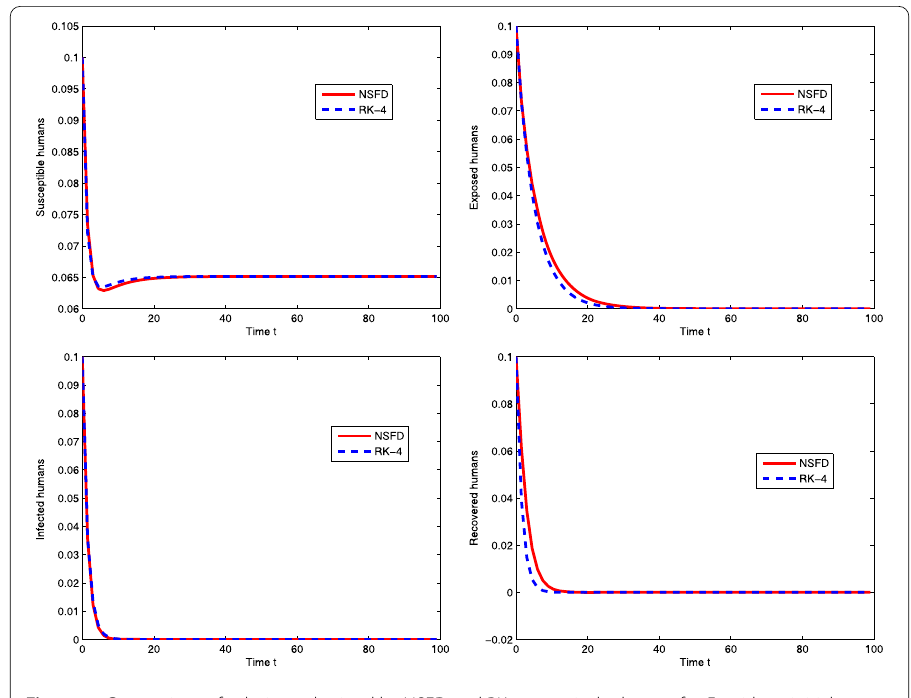
Figure 4 Comparison of solutions obtained by NSFD and RK4 numerical schemes for F 0 with an initial condition ( S (0), E (0), I (0), R (0)) = (0.1,0.1,0.1,0.1) and step size h = 1.5. Both the schemes converge to the true steady state of F 0 with R 0 = 0.2167 < 1